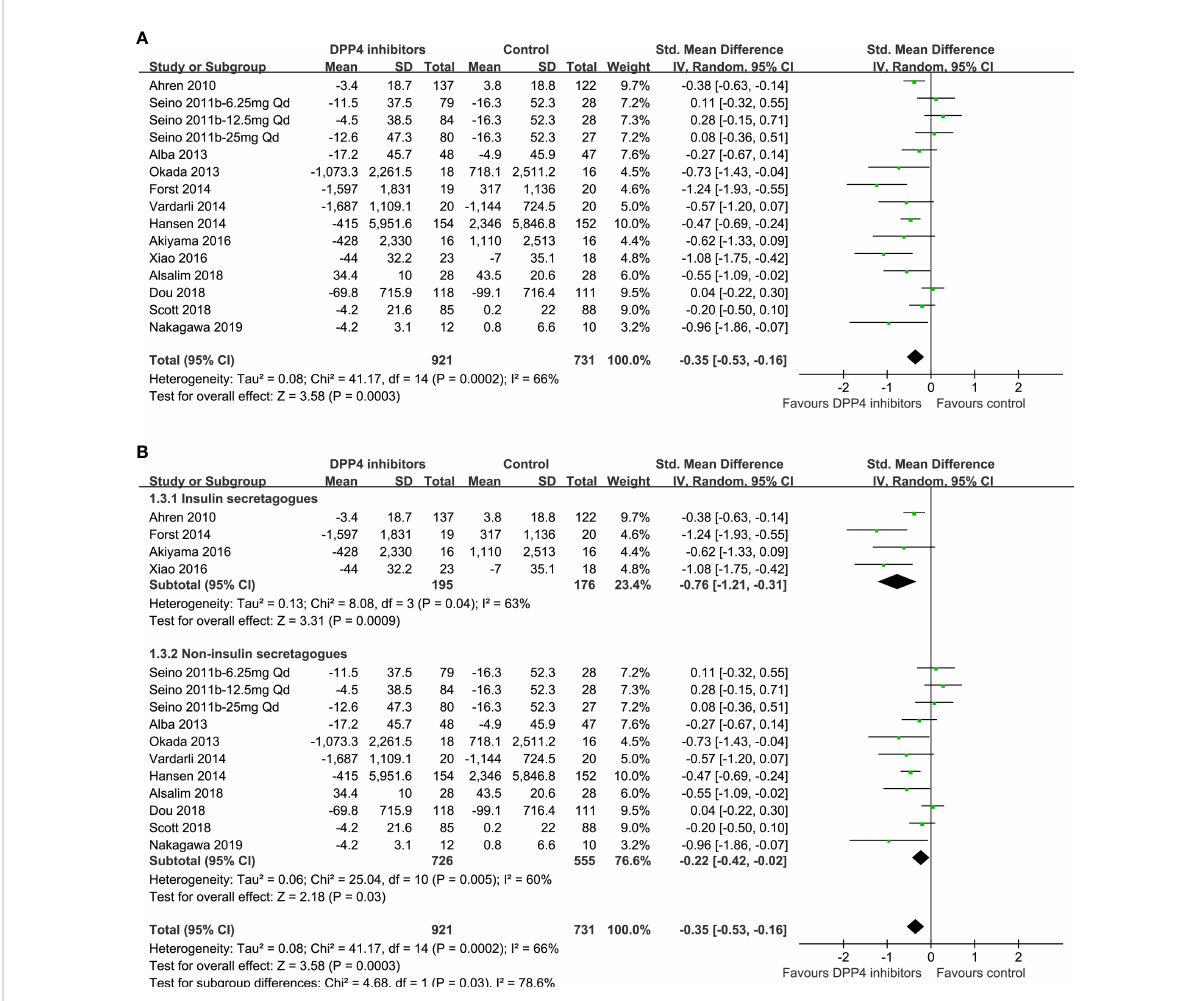
FIGURE 3 Forest plots for the meta-analysis comparing the effects of DPP4 inhibitors and other OADs on circulating glucagon levels in T2DM patients. (A) Forest plots for the overall meta-analysis; and (B) forest plots for the subgroup analyses according to the OADs given to